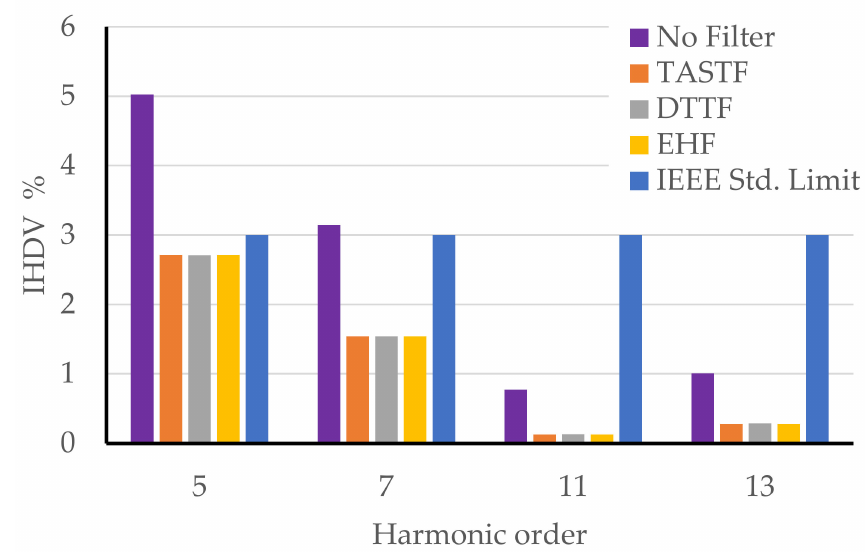
Figure 10. The individual load voltage harmonics.